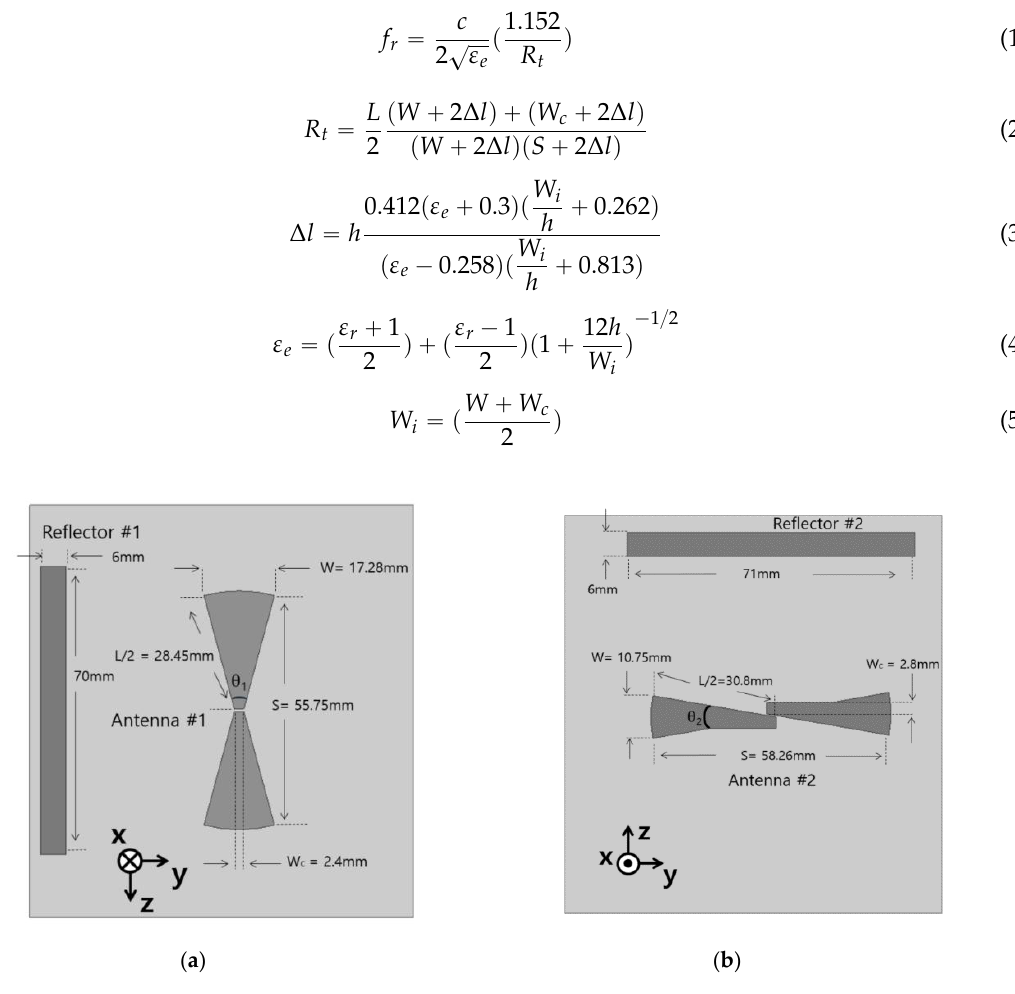
Figure 1. Layout of two inkjet-printed bow-tie antennas. ( a ) first antenna and ( b ) second antenna.